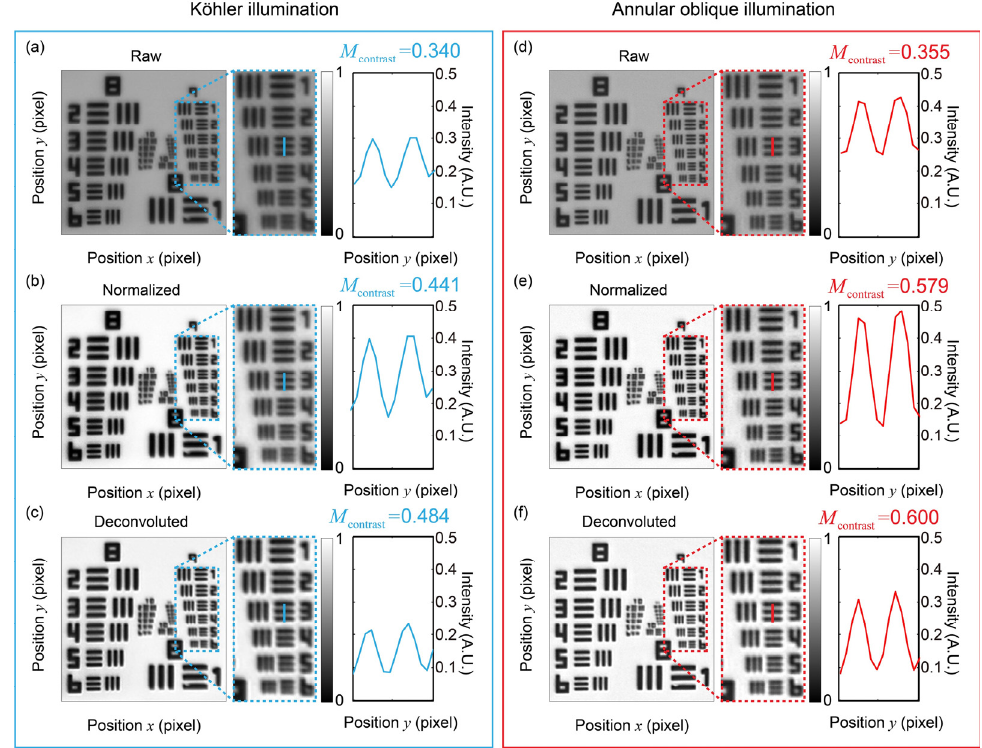
Figure 13. The resolution target images: ( a ) is a raw Köhler-illuminated image, ( b ) is the normalized image of ( a ), ( c ) is the deconvoluted image of ( b ); ( d ) is a raw annular oblique-illuminated image, ( e ) is the normalized image of ( d ), ( f ) is the deconvoluted image of ( e ).